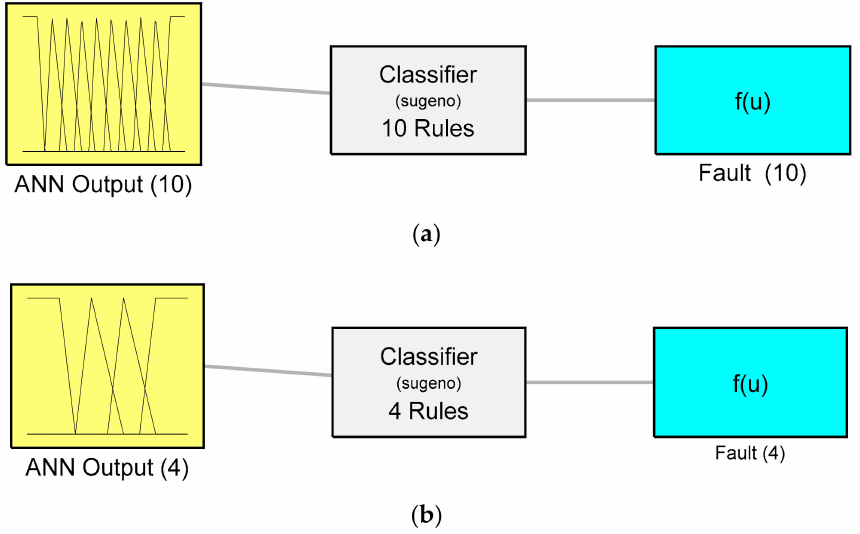
Figure 11. The developed fuzzy logic system ( a ) System 1 and ( b ) System